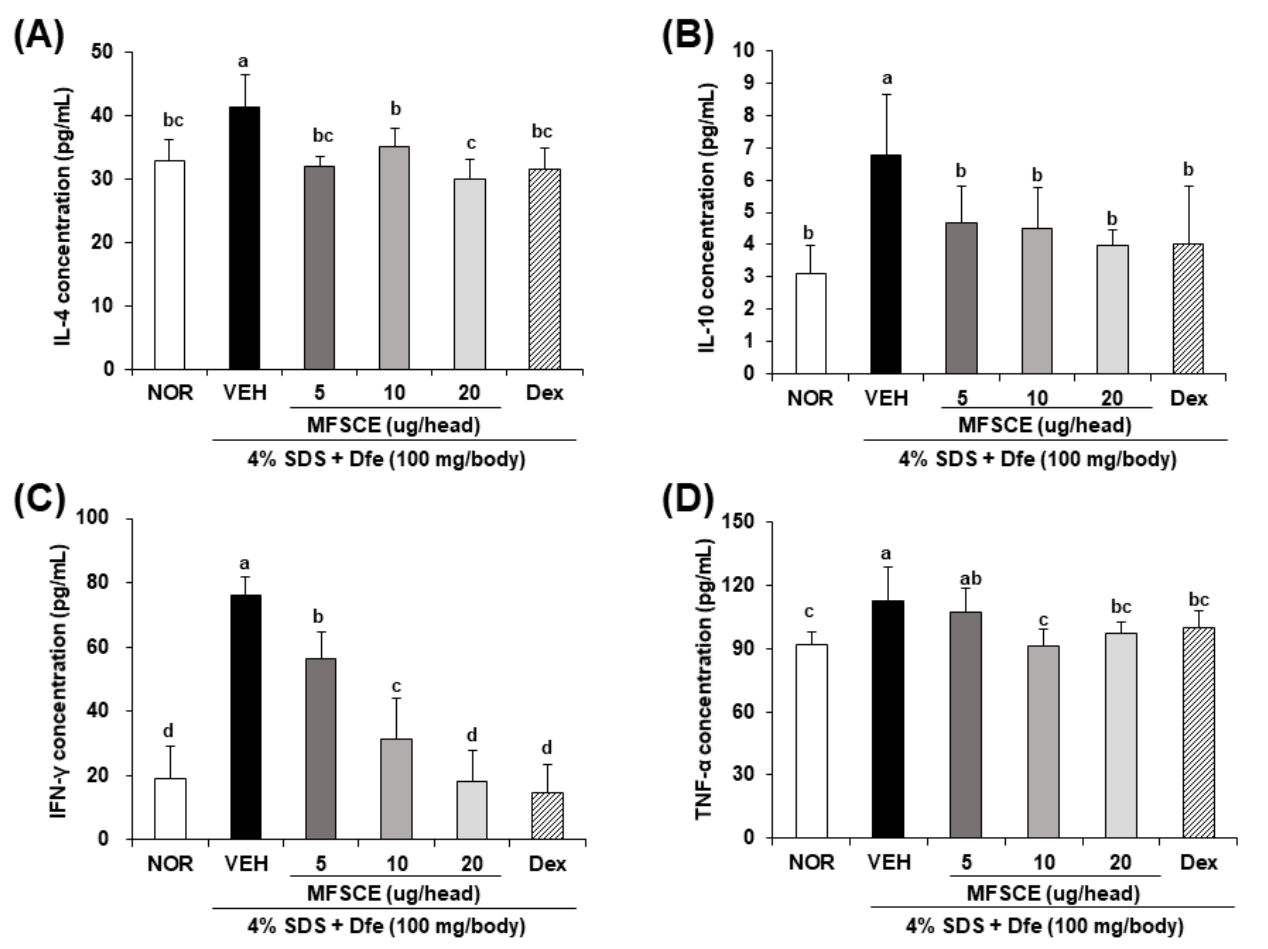
Figure 5. Effect of MFSCE on serum inflammatory cytokines in HDM-sensitized NC/Nga mice. The levels of IL-4 ( A ), IL-10 ( B ), IFN- γ ( C ), and TNF- α ( D ) in serum. Values are mean ± SD. a–d Means with different letters are significantly different ( p < 0.05) as determined by Duncan’s multiple range test. The mice were grouped and treated as described in Figure 2.